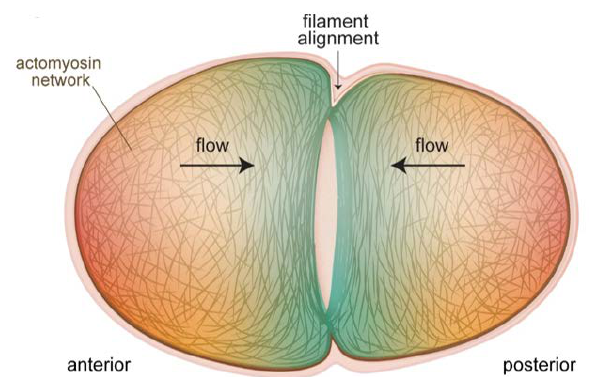
Figure 2. Cortical flows align filaments to form the contractile ring for cytokinesis of the one-cell embryo. The actomyosin cortex at the poles flows toward the equator of the embryo (black arrows), and these flows progressively transform the unorganized actin filament network at the poles (red shading) into the aligned structure of the cytokinetic ring (blue shading). In cases where actin-binding proteins are perturbed, thus altering cortical properties and flows, the formation and ingression of the contractile ring are impacted (see text).